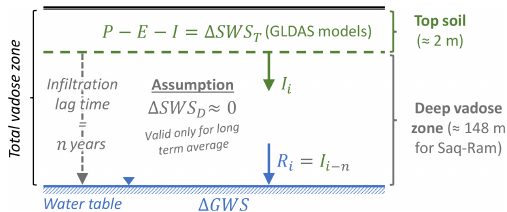
Figure 6. Conceptual representation of the treatment of the vadose zone in the GRACE–GLDAS water budget